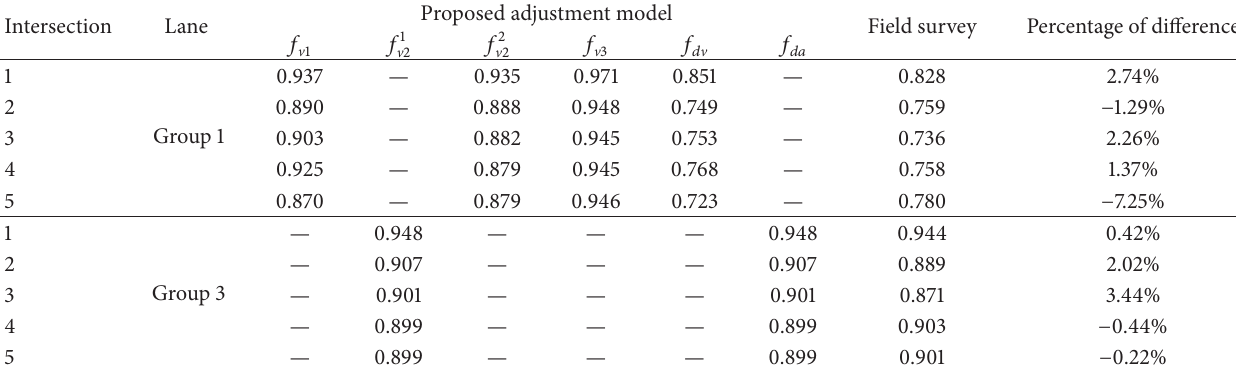
Table 13: Comparison of results between the proposed model and field survey.